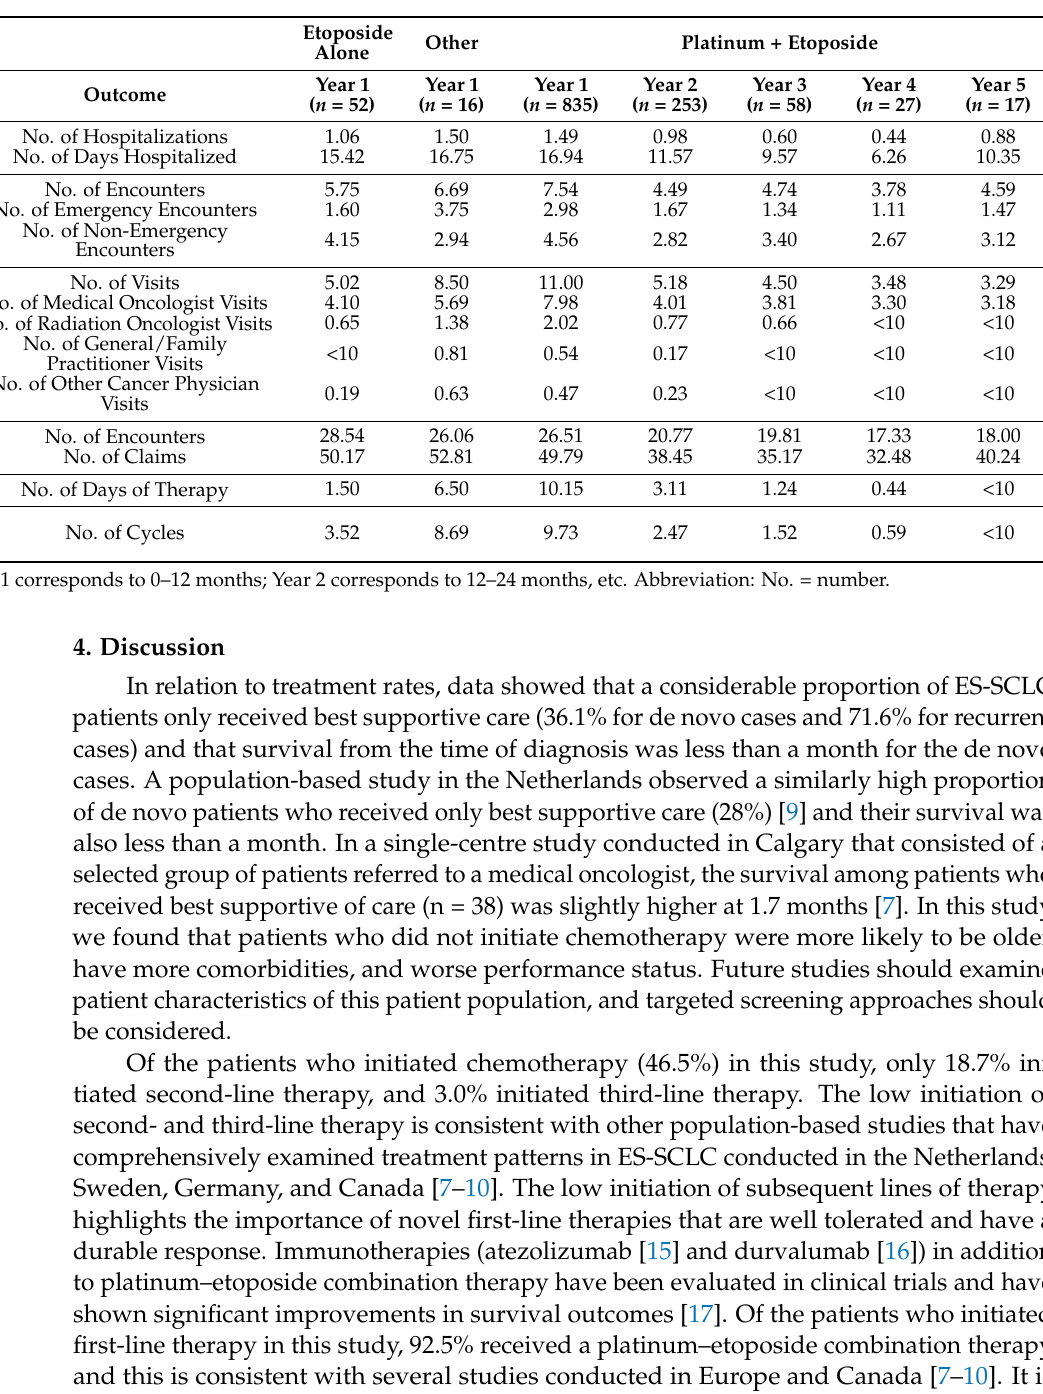
Table 3. Average health care resource utilization per patient per year from first-line therapy among de novo and recurrent ES-SCLC cases by treatment